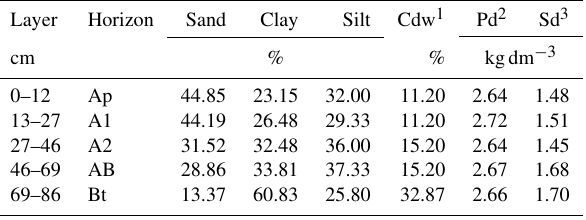
Table 1. Physical characteristics of the Argisol at the experimental sites. Source: Santos et al.